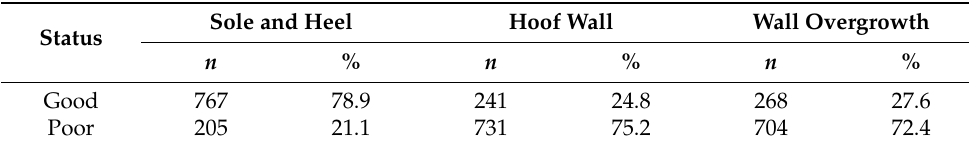
Table 5. Frequency distribution of good and poor states of three hoof conformation variables for 972 foot-level